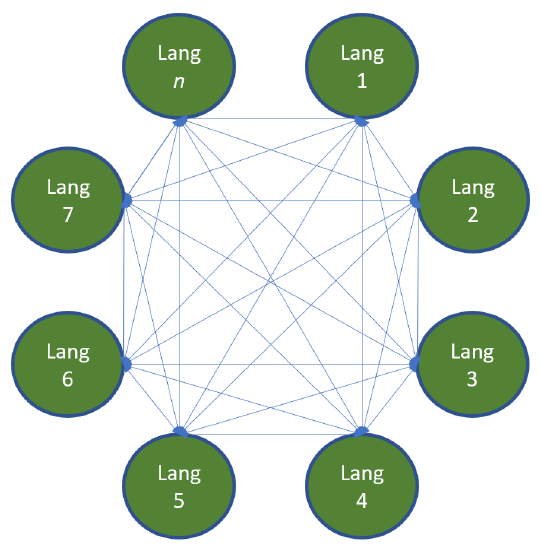
Figure 4. The Typological parallel corpus architecture (illustrated for n languages).